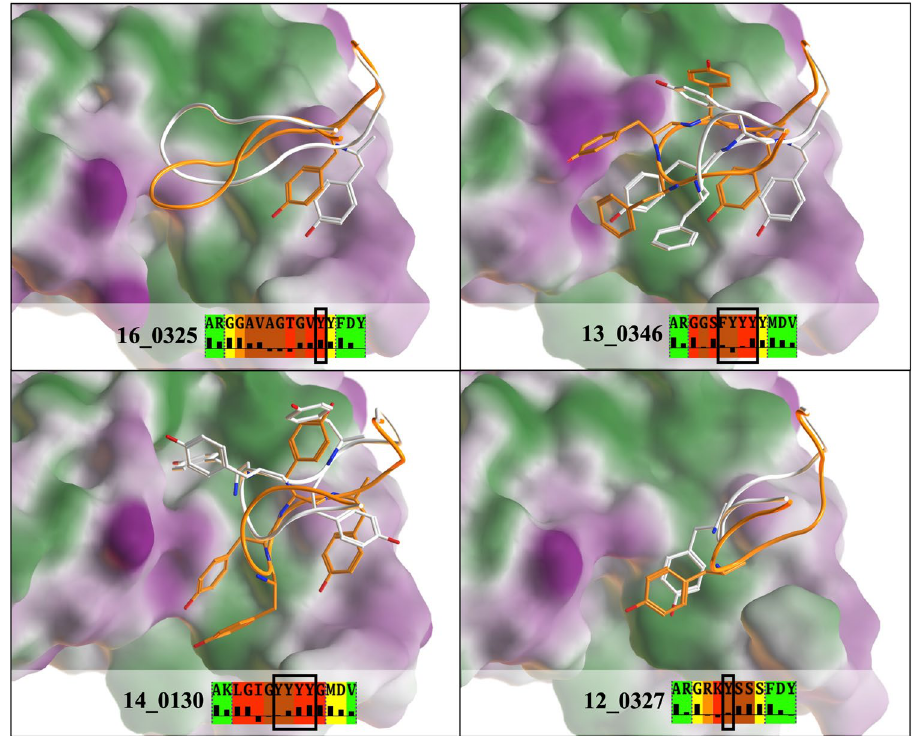
Figure 8. Non-polar interactions made by aromatic residues compensate for structural inaccuracies in H3 redesign. The H3 loop conformations are rendered as tubes colored white for the crystal structure and orange for the modeled structure corresponding to the lowest Talaris energy. Aromatic residues from each H3 loop boxed in the BRMSD/SASA diagrams (as per Fig. 6) are displayed with capped sticks. A molecular lipophilicity surface of the VEGF antigen is rendered for the crystal structure determined for each design (Green = Lipophilic, Purple = Hydrophilic, White = Neutral, Created in MOE).